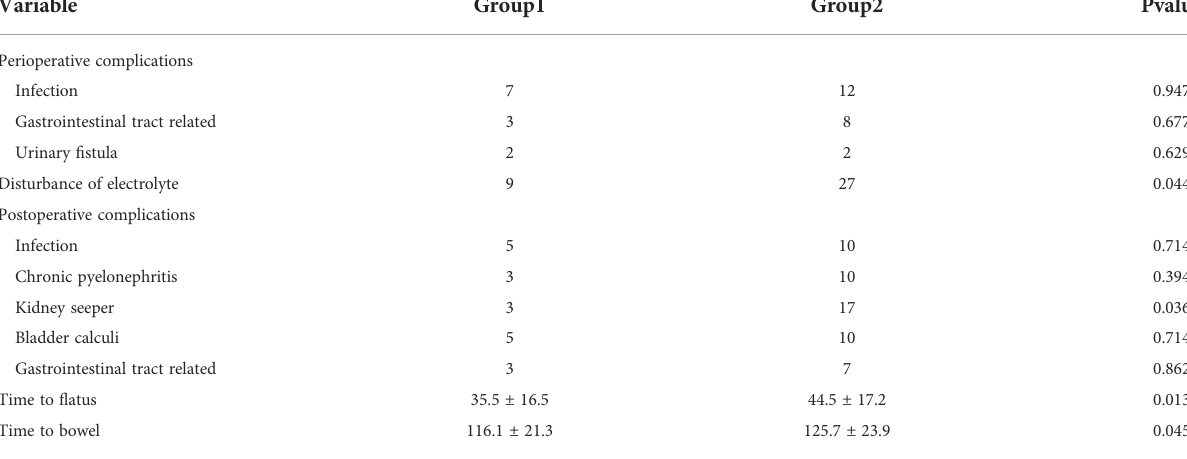
TABLE 1 Perioperative and postoperative information of the two